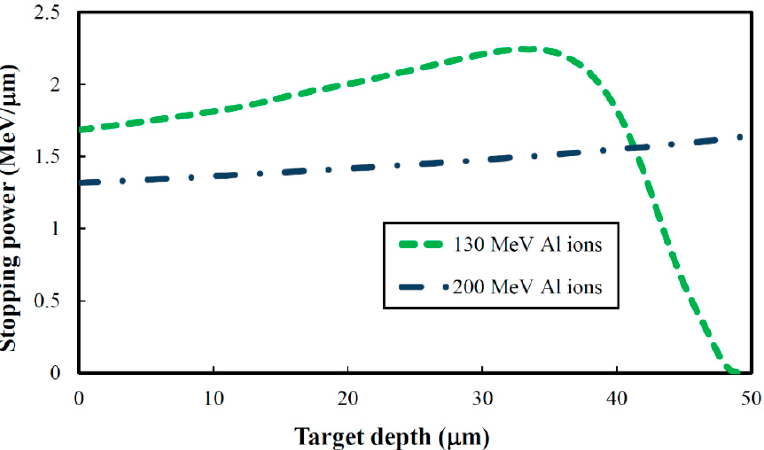
Figure 3. Stopping power of the 50 µm thick phosphor layer of a BAS-TR IP for 130 MeV and 200 MeV Al ions as functions of the target depth. The area under the curve represents the deposited energy in the phosphor layer.